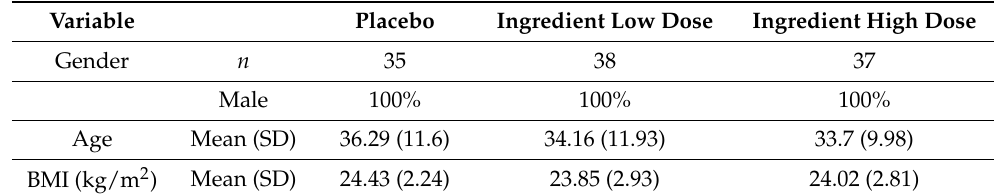
Table 2. Baseline characteristics of subjects. No significant differences were observed between the groups with respect to age and